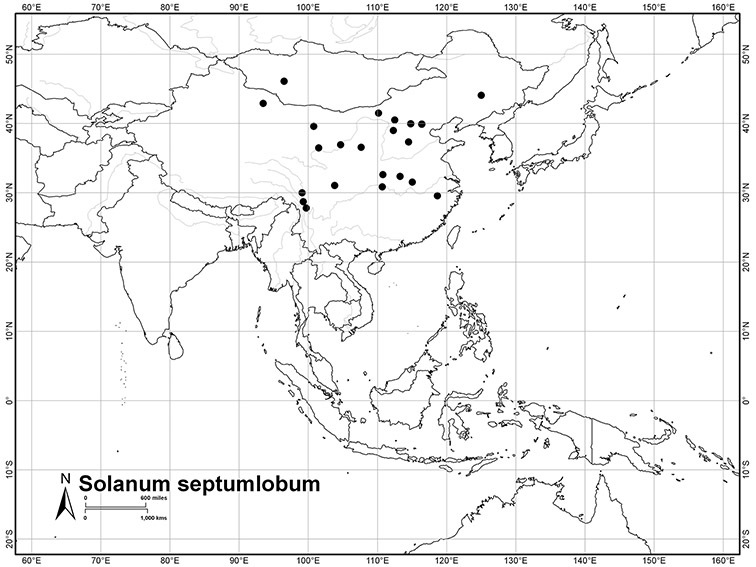
Distribution of Solanum septumlobum Bunge.